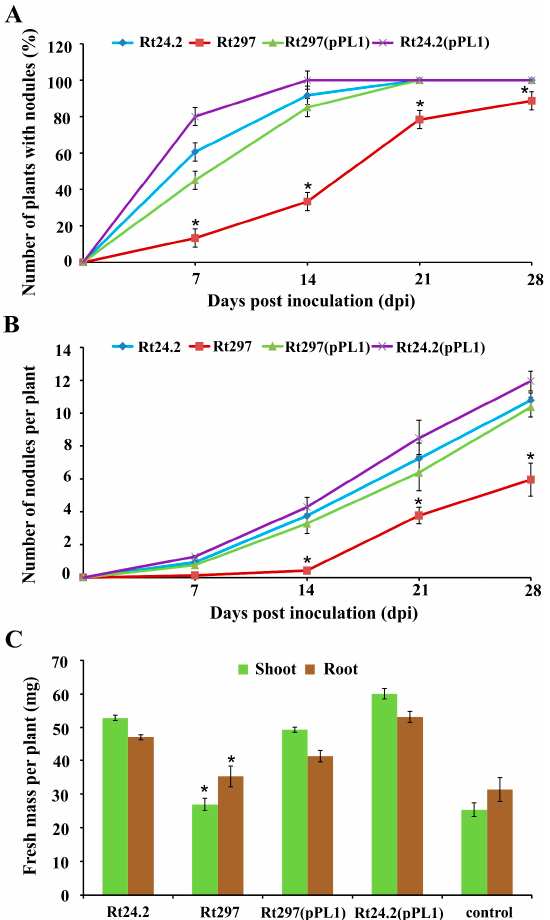
Figure 10. Effectiveness of clover root infection by the wild-type strain R. leguminosarum Rt24.2 and several derivatives presented as the percent of tested plants forming nodules ( A ); the number of nodules elicited by the studied strains on clover roots ( B ); and the shoot and root masses of 28-dpi clover plants inoculated with the different strains ( C ). Control, uninoculated clover plants. The values are averages ± SD of three independent experiments using 20 plants for each strain tested. * Significant differences between the Rt297 mutant and the wild-type Rt24.2 strain ( p < 0.05, Student’s t -test).